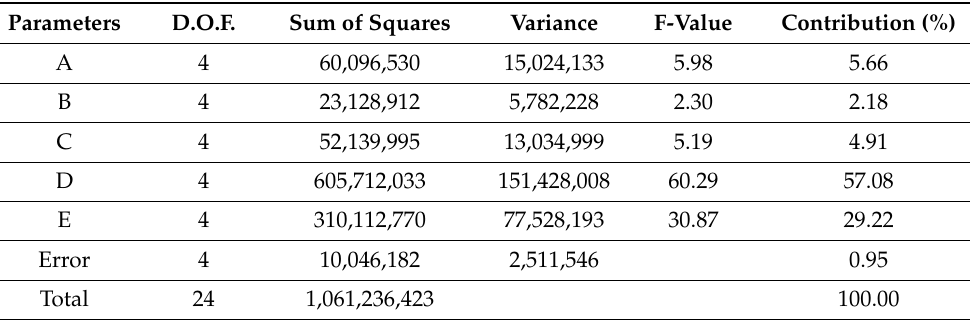
Table 11. ANOVA for the pressure